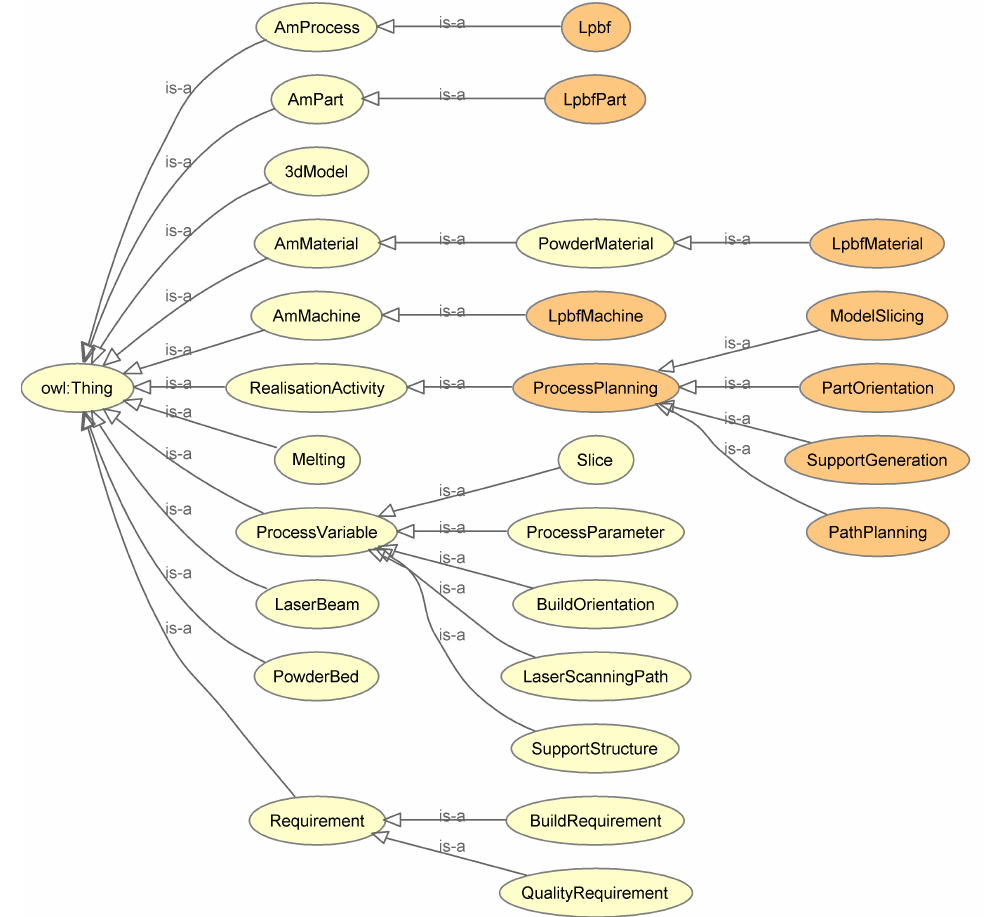
Figure 3. Graphical representation of top-level concepts and their